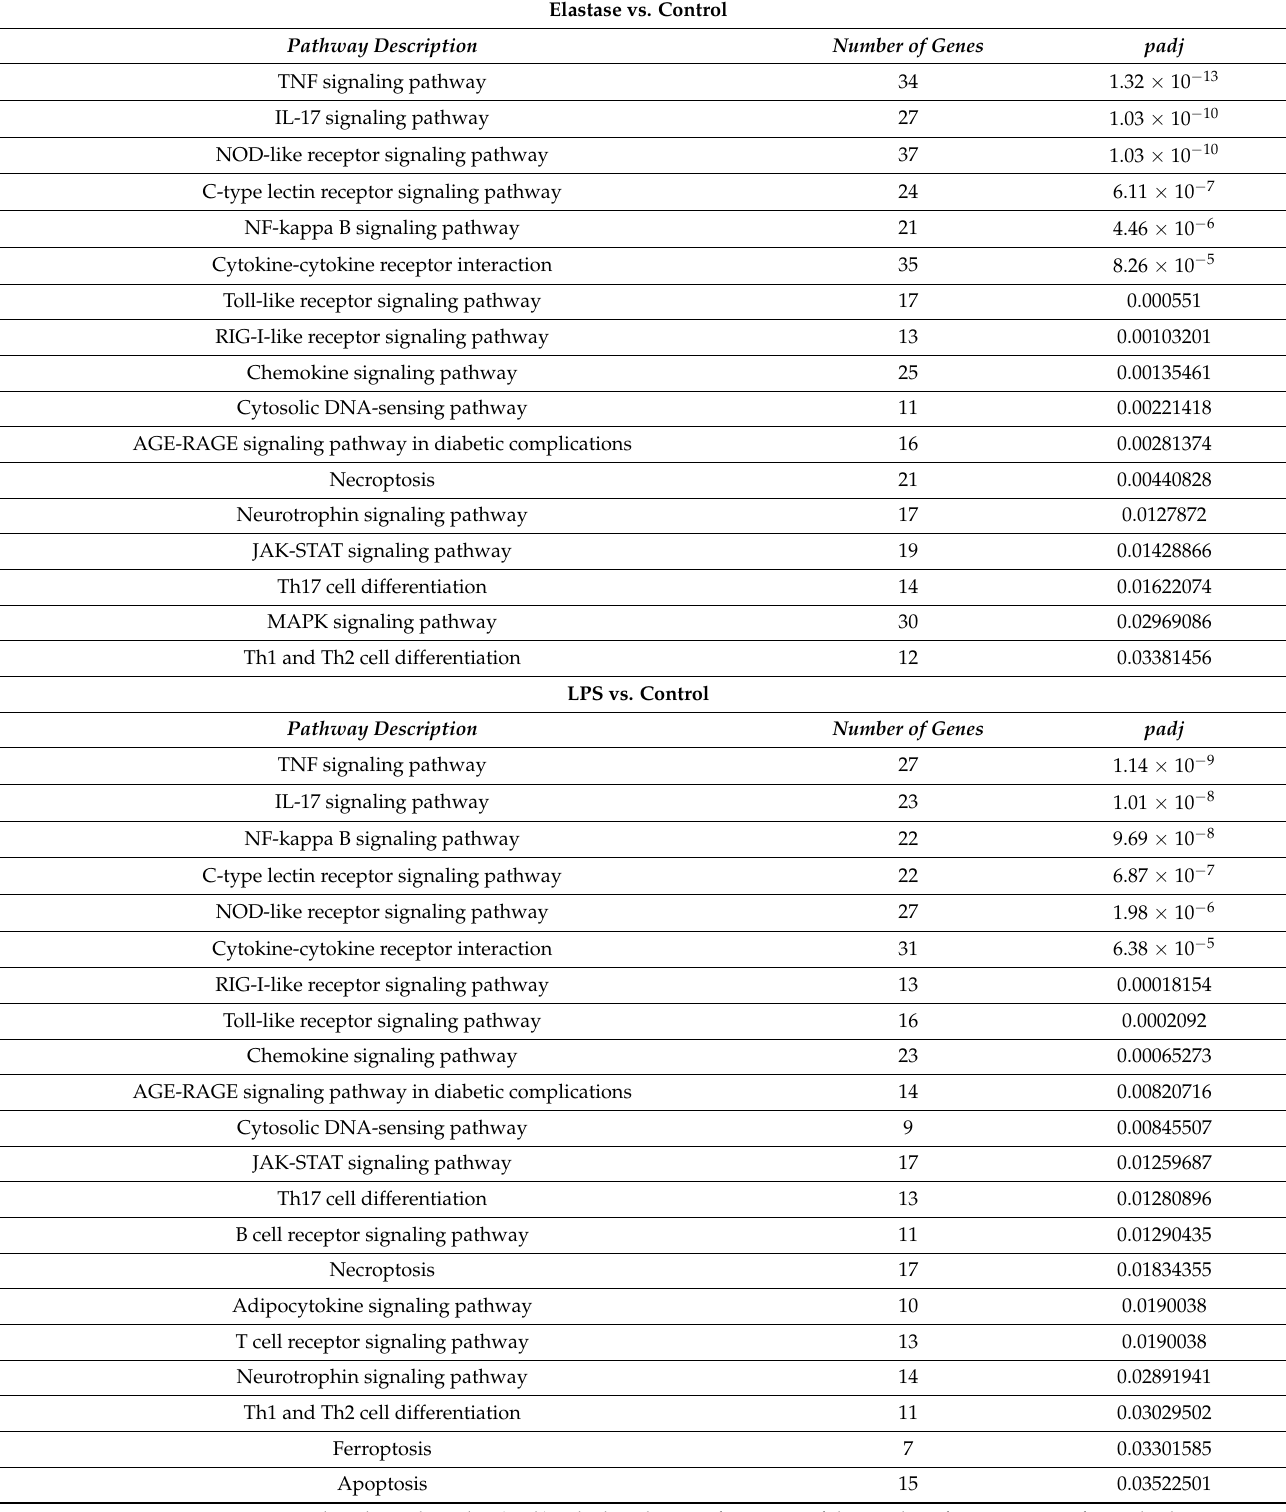
Table 2. KEGG Metabolic Enrichment